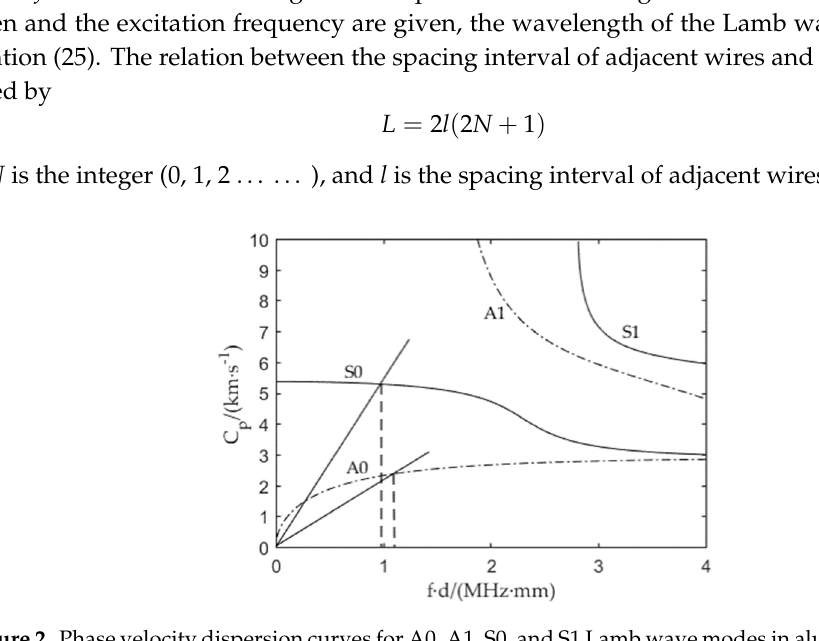
Figure 2. Phase velocity dispersion curves for A0, A1, S0, and S1 Lamb wave modes in aluminum plates.